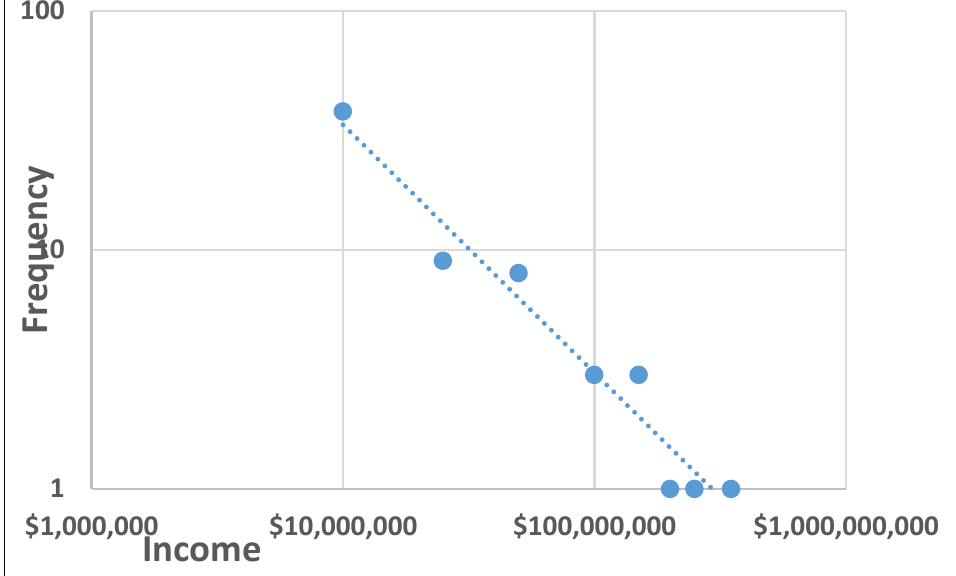
Figure 3. AUTM binned data plotted on a log–log scale. Narrowing the data analyses from a collection of universities to individual universities, one finds similarly skewed income distributions. Figure 4 compares the income histories of two different universities, one with a medical school and the other without one. One set of data is from 1984–1998, and the other is from 2000–2017. The two schools’ curves are similar, ignoring inflation. They resemble AUTM income and venture capital return curves: a few licenses generate a significant fraction of the total income, and most licenses generate minimal income. Like the AUTM data, if one plots the income data on a log–log scale, the data approximate a straight line, indicating a power-law distribution. The two universities’ income data largely overlap; however, one school generated significant income, and the other lost money in most years.